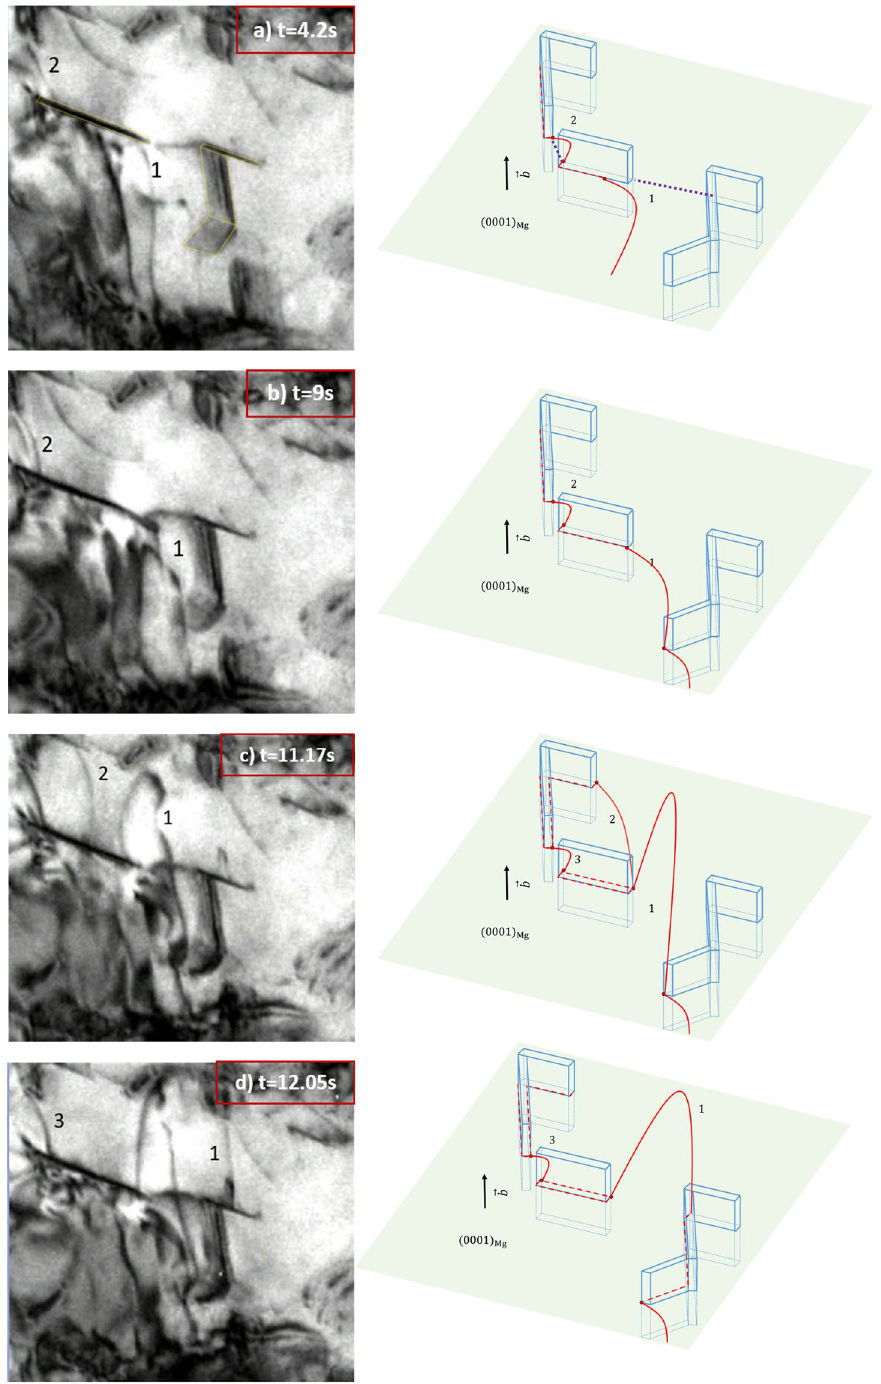
Figure 3. TEM images of motion of dislocations on basal (0001) plane thread through two parallel precipitates. Schematics in the right column correspond to the recorded frame at left. The viewing direction [1213] of images relative to schematics is shown in schematic ( a ). The precipitates of interest are also outlined in ( a ). Initial dislocation line direction is represented as purple dotted line in ( a ). After segment 2 glides out of view, a following dislocation segment 3 is pinned in ( c ) and ( d